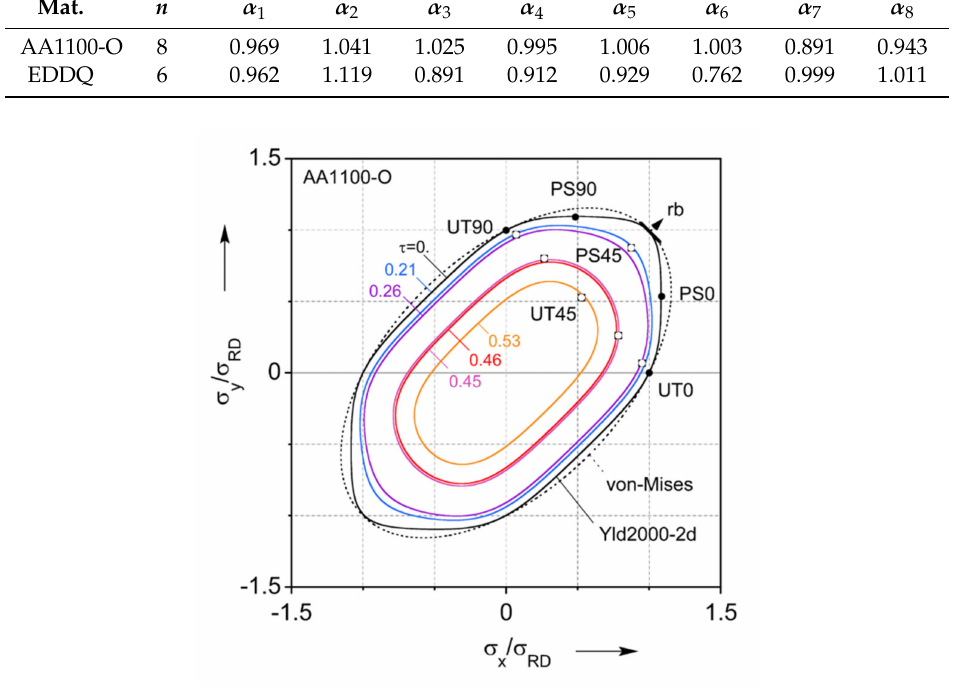
Figure 9. Yield loci predicted by Yld2000-2d (solid lines) and von-Mises (dashed line) with experiments (symbols) used for the parameter